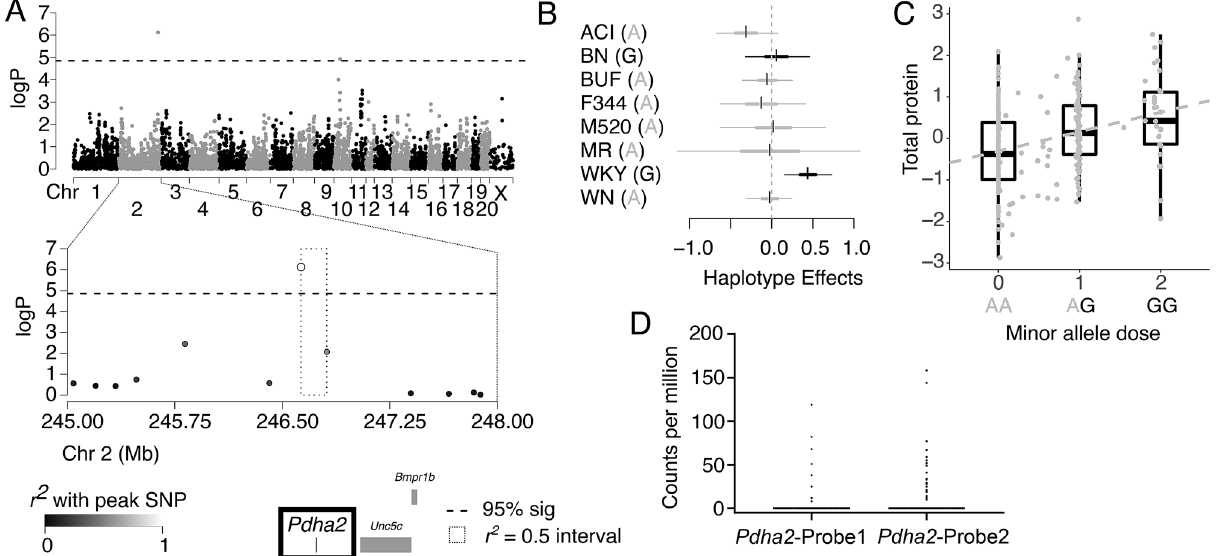
Figure 2. Genome-wide scan and founder effects at the chromosome 2 QTL for UPE. ( A ) Genome scan for UPE shows significant loci on chromosomes 2 and 10. The x-axis is the position on the chromosome, and the y-axis is the − log 10 P level of association. Genome-wide significance thresholds were calculated using parametric bootstraps from the null model. Linkage disequilibrium support interval (highlighted as a dashed line box) of the chromosome 2 locus is only 0.18 Mb and contains a single gene, Pdha2 (bold). ( B ) Additive haplotype effects were estimated using the Diploffect model, taking into account uncertainty in haplotype state. Single-nucleotide polymorphism (SNP) allele information is overlaid on the haplotype effects, with minor allele colored black and major colored gray. The WKY haplotype significantly increases urinary protein at this locus. ( C ) Effect of genotype at the peak marker on urinary protein reveals that the G allele is associated with increased urinary protein. Boxplots represent data categorized by most likely genotype. ( D ) Targeted RNAseq data demonstrating very limited expression of Pdha2 in the kidney using two separate probes. These data, together with a lack of potentially damaging variants in this gene and lack of support from mediation analysis, suggest that Pdha2 is not the causal gene at this